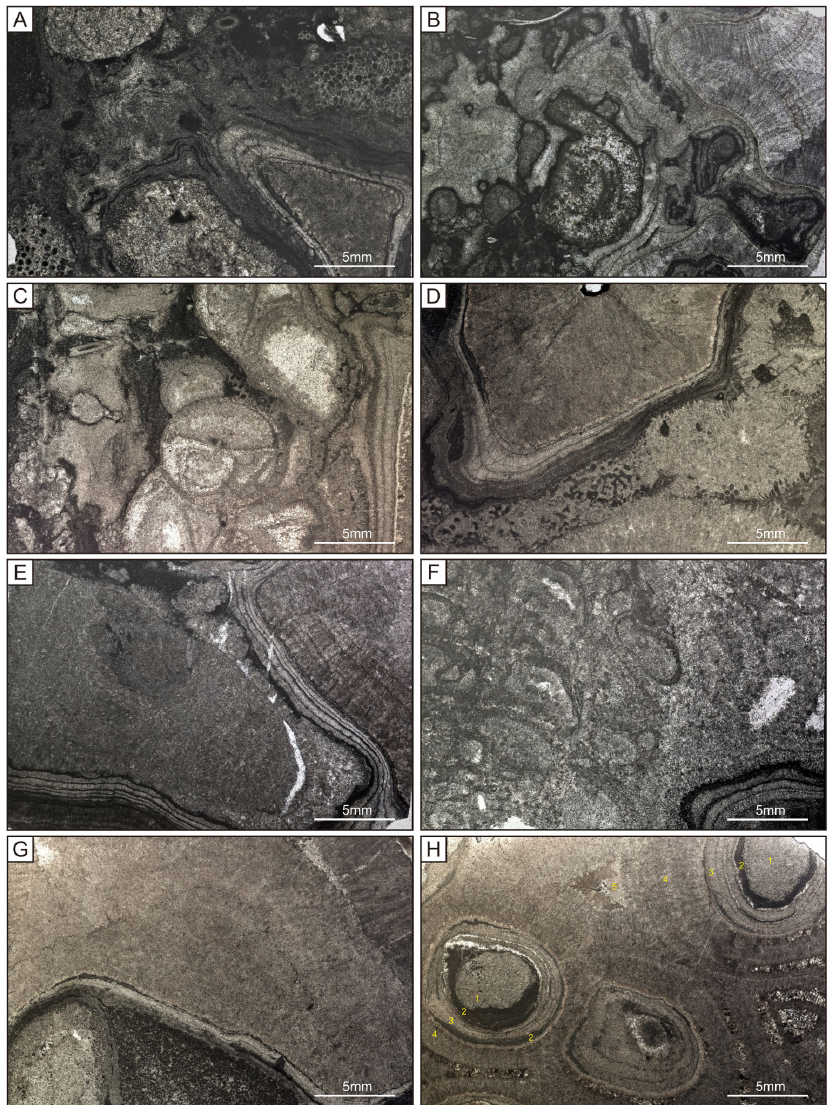
Figure 8. Photomicrographs of microfacies belong to photozoan reef stage: ( A , B ) the bioclastic limestone part of the binding-skeleton sponge bafflestone; algae encrusted the sponge; interspace is filled by multiple calcite cement. ( C , D ) the binding-skeleton sponge part of the bafflestone; fibrous calcite cement wrapped sponge skeleton. ( E , F ) binding-skeleton sponge framestone; algae and calcite wrapped the out-side of the agglomerated sponge block; ( G , H ) open-skeleton sponge framestone showing the filling order between the sponge skeleton: (1) sponge; (2) Archaeolithoporella ; (3) fibrous calcite; (4) radiaxial fibrous calcite; (5) blocky